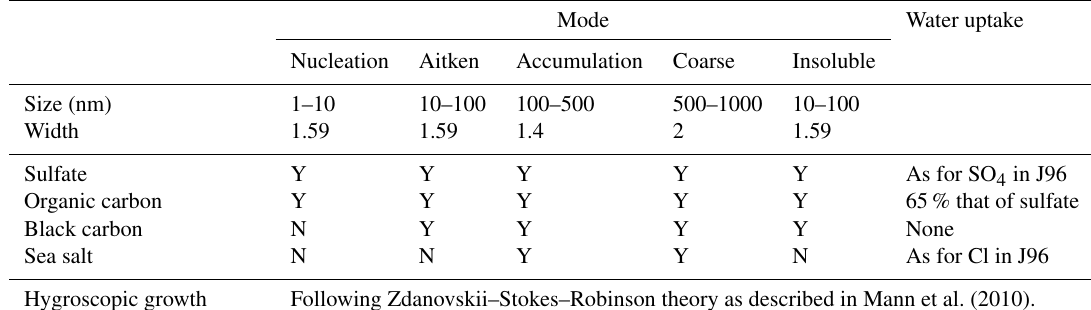
Table 1. Description of aerosol modes and parameterisations in the model. Y/N: yes/no, i.e. if Y, this species is allowed to exist in this mode. J96: Jacobson et al.